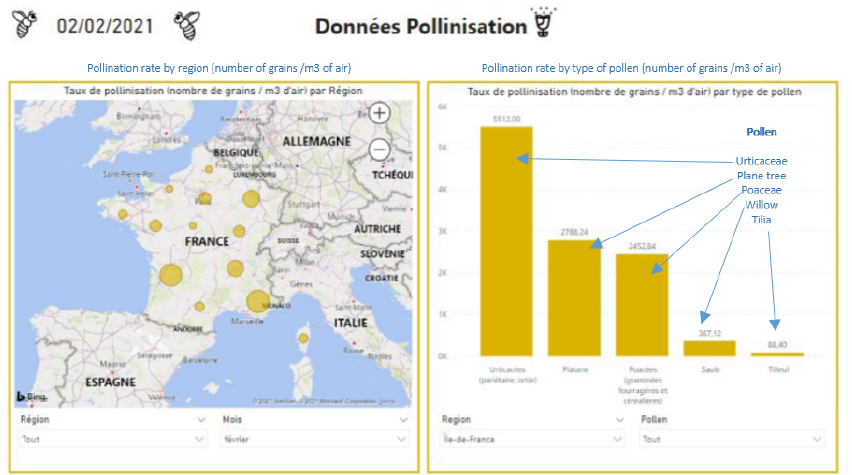
Figure 13. Dashboard: pollination